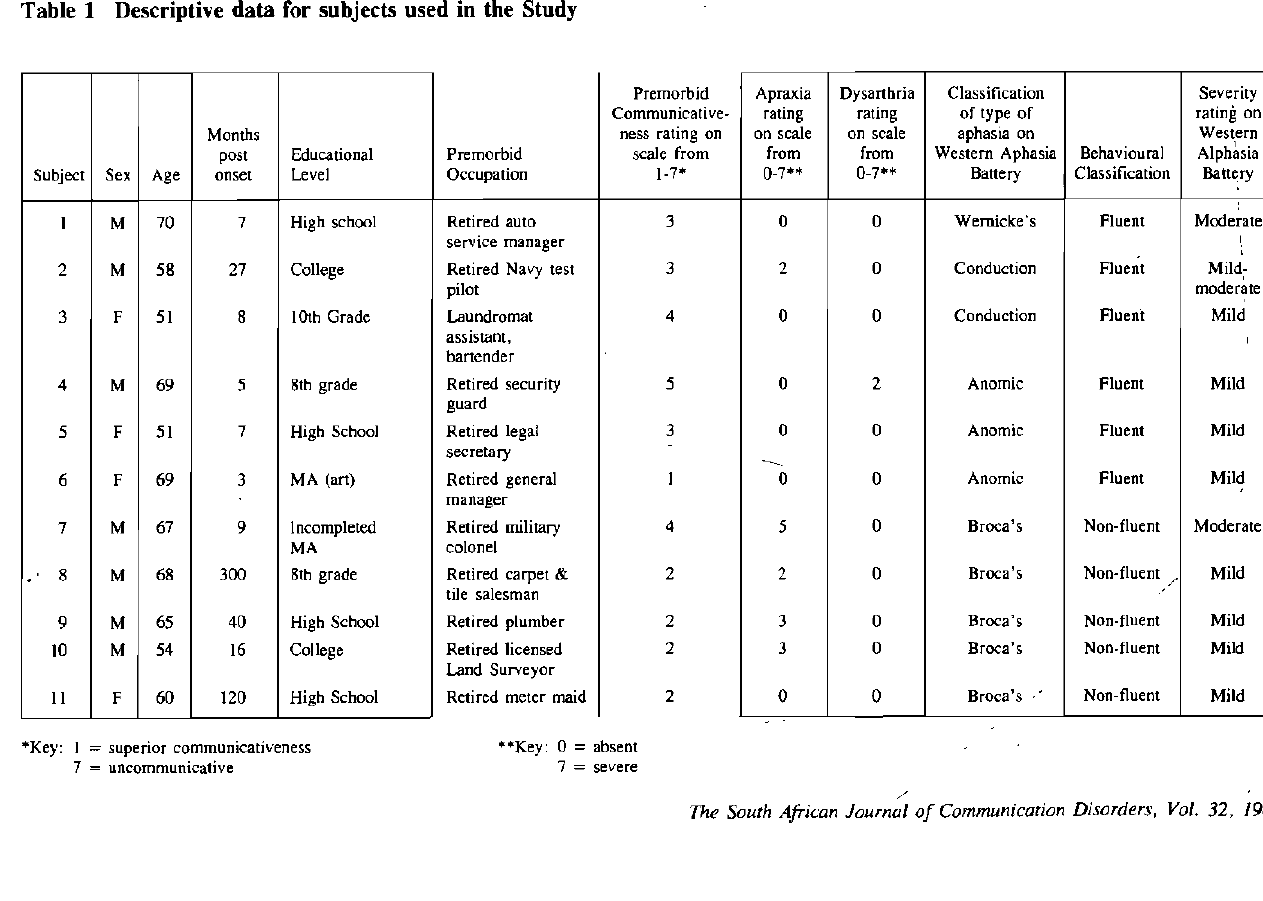
Table 1 Descriptive data for subjects used in the